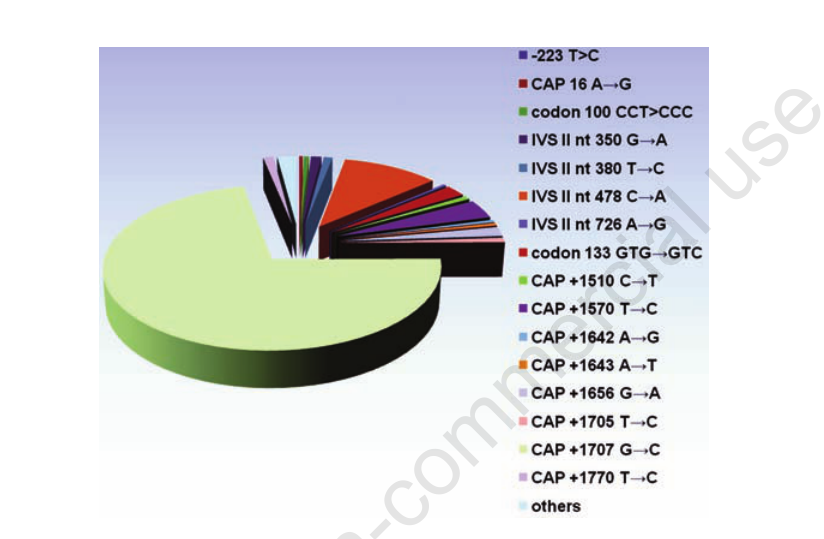
Figure 2. Frequency of the 27 nucleotide changes identified within the β -globin gene.